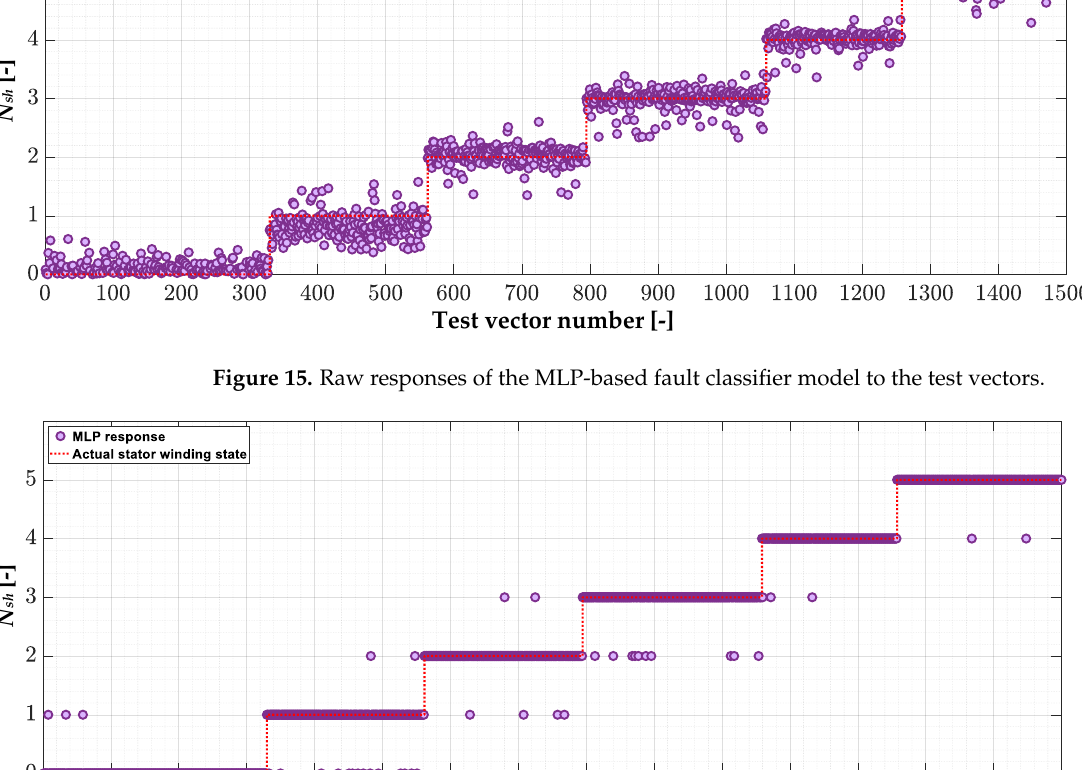
Figure 16. Rounded responses to the nearest integer of the MLP-based fault classifier model to the test vectors.